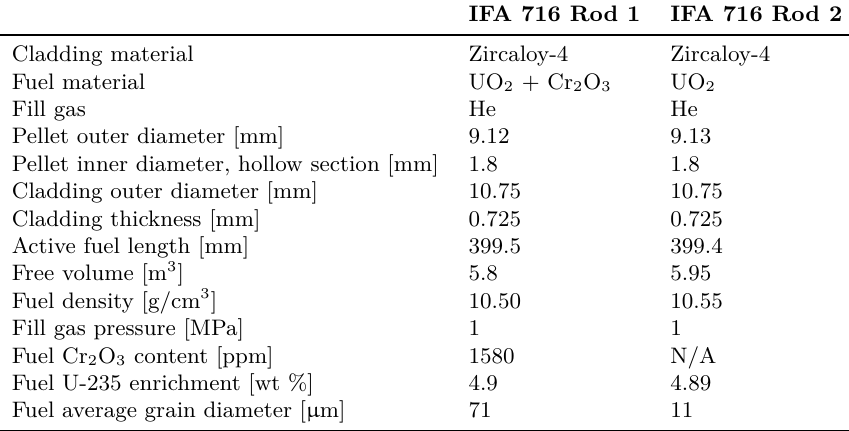
Table 3. Fuel characteristics of IFA 716 rod 1 and 2 simulated in this work [11].